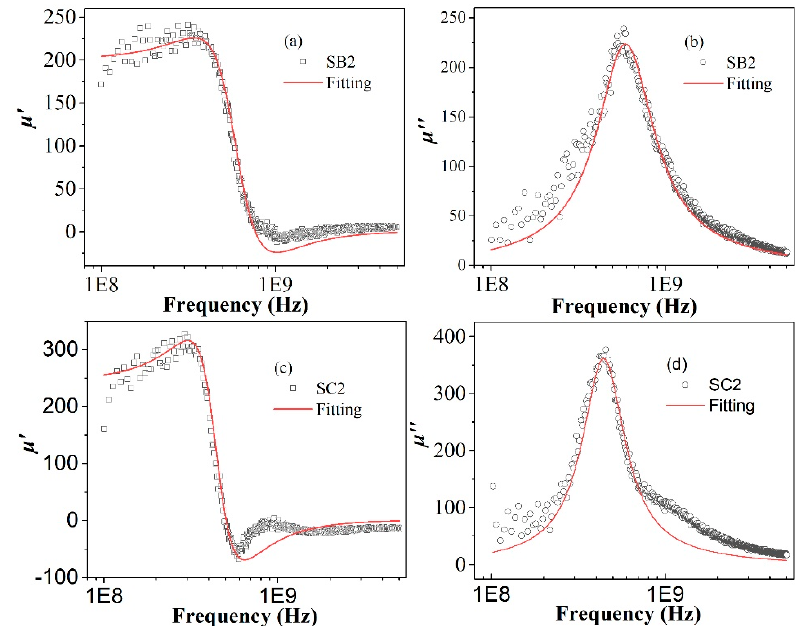
Figure 6. The fitting curves of the real permeability and imaginary permeability for SB2 and SC2. ( a ) and ( b ) show the fitting curves of SB2. ( c ) and ( d ) show the fitting curves of SC2.